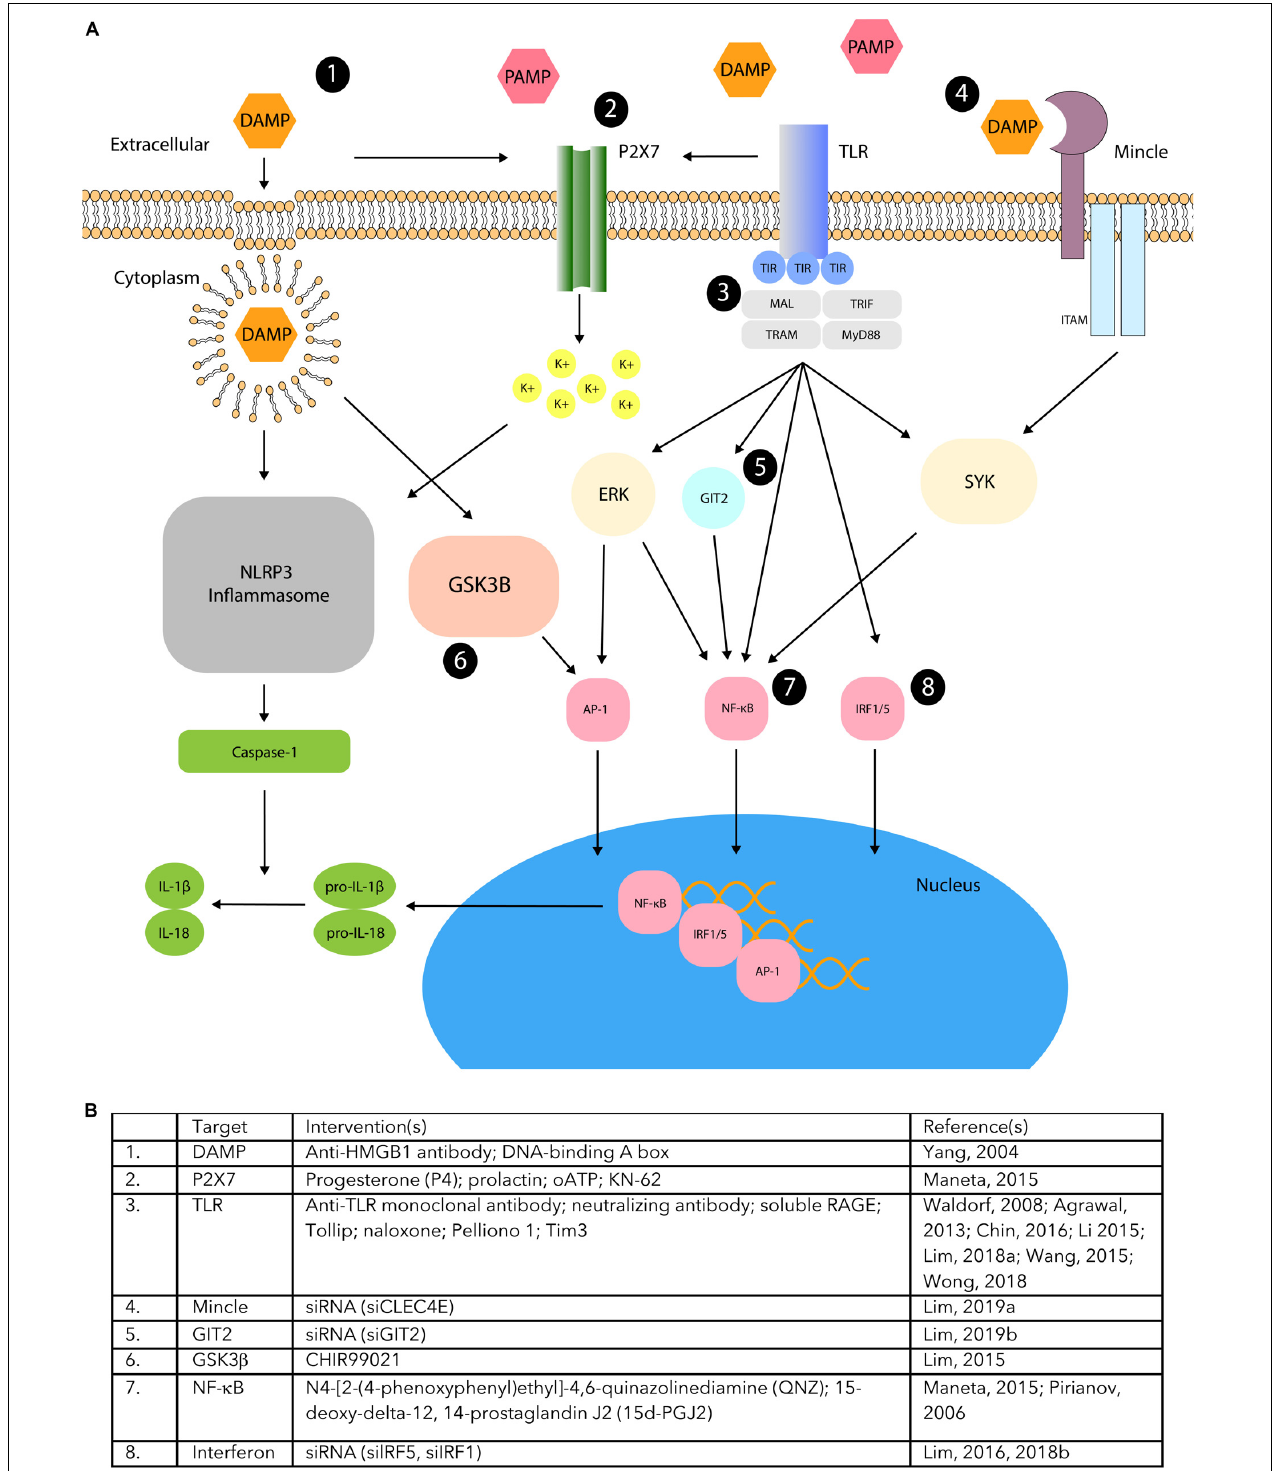
FIGURE 2 | DAMP/PAMP PPR pathway manipulation. (A) TLR, Mincle, and P2X7 receptor activation regulated by DAMP and PAMP signaling have been shown to stimulate downstream pathways involving various modulatory proteins (ERK, GSK3B, GIT2, SYK). This may activate AP-1, NFkB, IRF1/5, or inflammasome activation that leads to induction of pro-inflammatory cytokines. Studies have demonstrated different areas of modulation (1–8) that can manipulate DAMP/PAMP mediated inflammation associated with PTB. (B) The supporting table lists several interventions that demonstrate the manipulation of the DAMP/PAMP mediated pathways that correspond to the different areas of